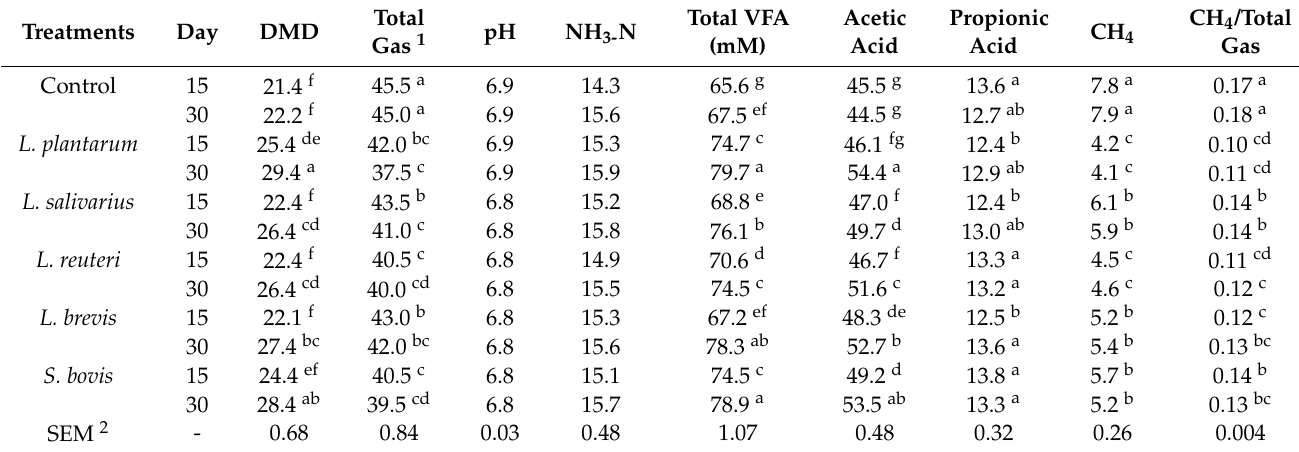
Table 5. Effects of inoculation of LAB on in vitro rumen fermentation.